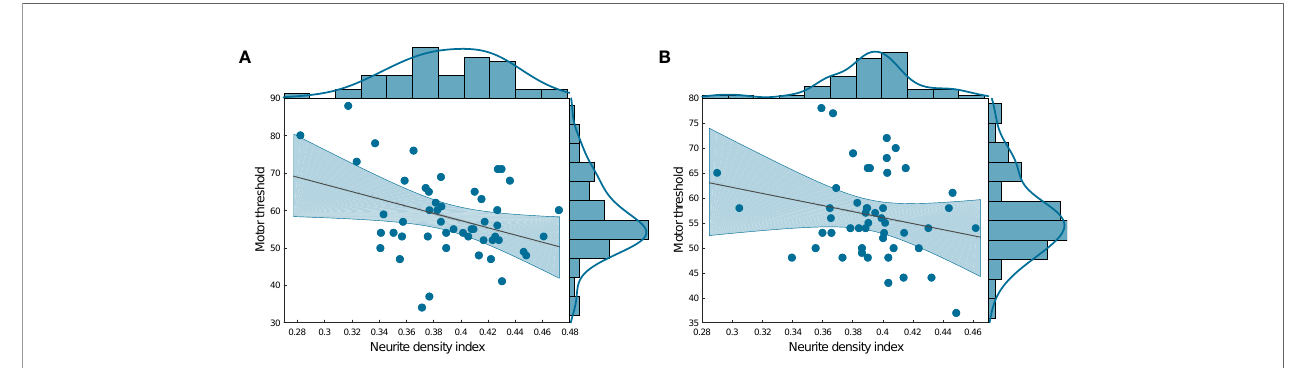
FIGURE 2 | Scatterplot with regression line and density estimates of the regression of motor threshold on neurite density index in (A) patients with MS and (B) HC. HC, healthy controls, MS,